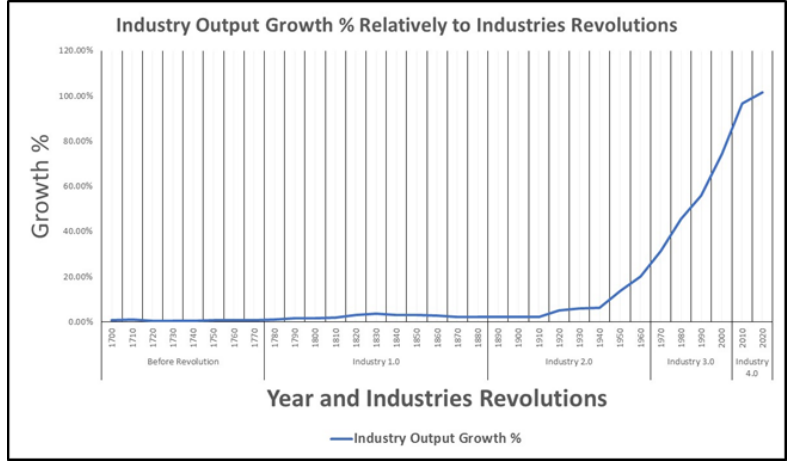
Fig. 1. Industry Output Growth Percentage Relative to Industry